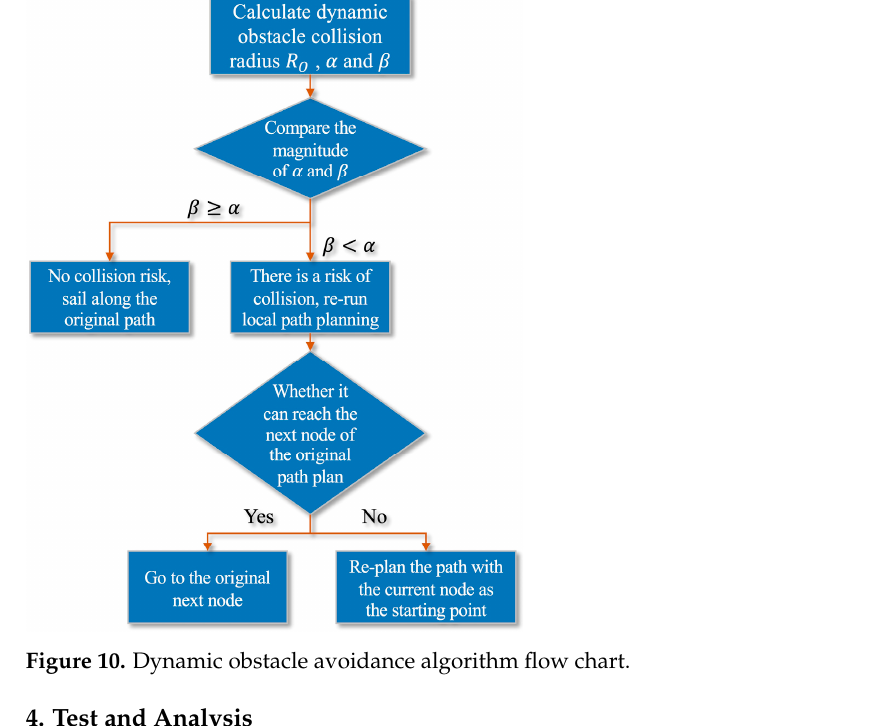
Table 3. Parameter